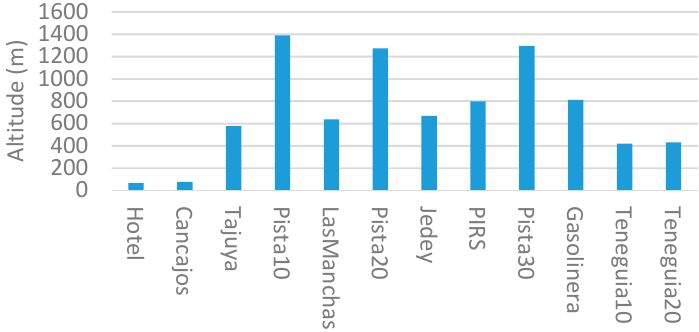
Figure 9. Graphic representation of the altitudes of the different stations in the micro-gravimetric network on La Palma Island.